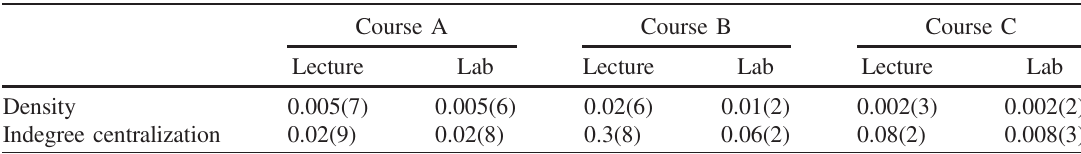
TABLE III. Network-level statistics for all observed networks. Density is the proportion of observed to possible edges. Indegree centralization is the extent to which the nominations are concentrated around one or a few students. Standard errors of the last digit are shown in